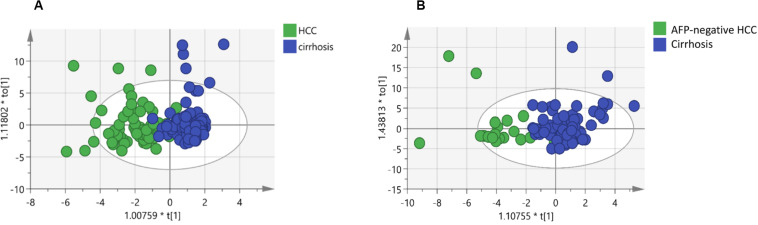
Identification of potential biomarkers through OPLS-DA: (A) Score plots obtained from the cirrhosis (n = 104) and HCC patients (n = 72). (B) Score plots obtained from the cirrhosis (n = 104) and AFP-negative HCC (n = 24) patients. Different colors of these dots represent different groups which are well separated based on sphingolipid levels. Also, the data indicate serum sphingolipidome varies significantly among groups. The scatter plot of t[1] vs to[1] is a window in the X space in which the separation of the two classes of observations occurs in the horizontal (t1) direction. The vertical (to[1]) direction expresses within class variability. * means t[1] or to[1] multiply by a coefficient, all these were automatically generated by the SIMCA software.